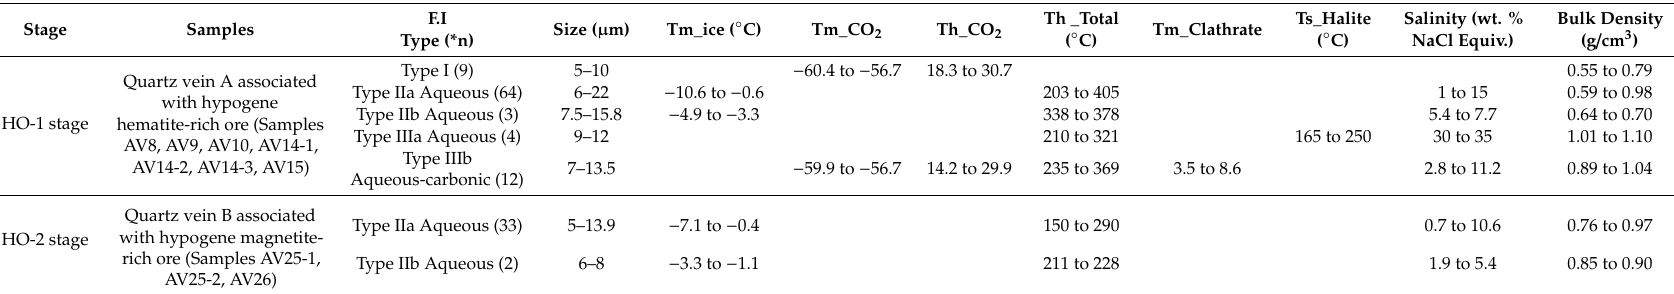
Table 1. Summary of microthermometric data and calculated parameters for fluid inclusions in vein quartz associated with Nabeba hypogene iron ores.